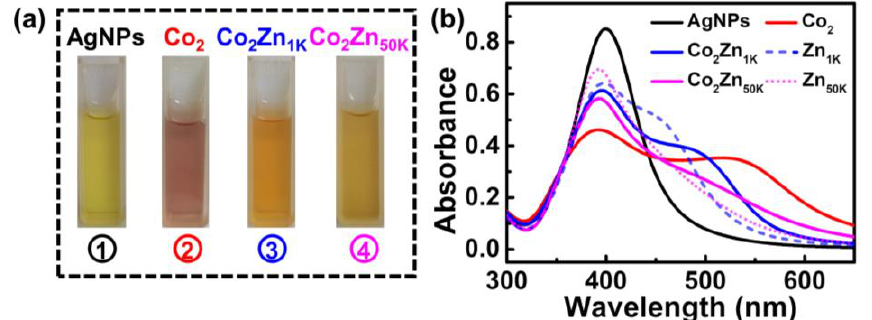
Figure 2. ( a ) Photographic images of PVP-AgNPs sensing solutions: ① PVP-AgNPs; ② PVP-AgNPs + 2 mg/L Co 2+ ; ③ PVP-AgNPs + 2 mg/L Co 2+ + 1 g/L Zn 2+ ; ④ PVP-AgNPs + 2 mg/L Co 2+ + 50 g/L Zn 2+ (from left to right). ( b ) Solid line (black, red, blue, and pink color): the corresponding absorption spectra of ( a ), short dash (blue): AgNPs + 1 g/L Zn 2+ , short dot (pink): AgNPs + 50 g/L Zn 2+ .